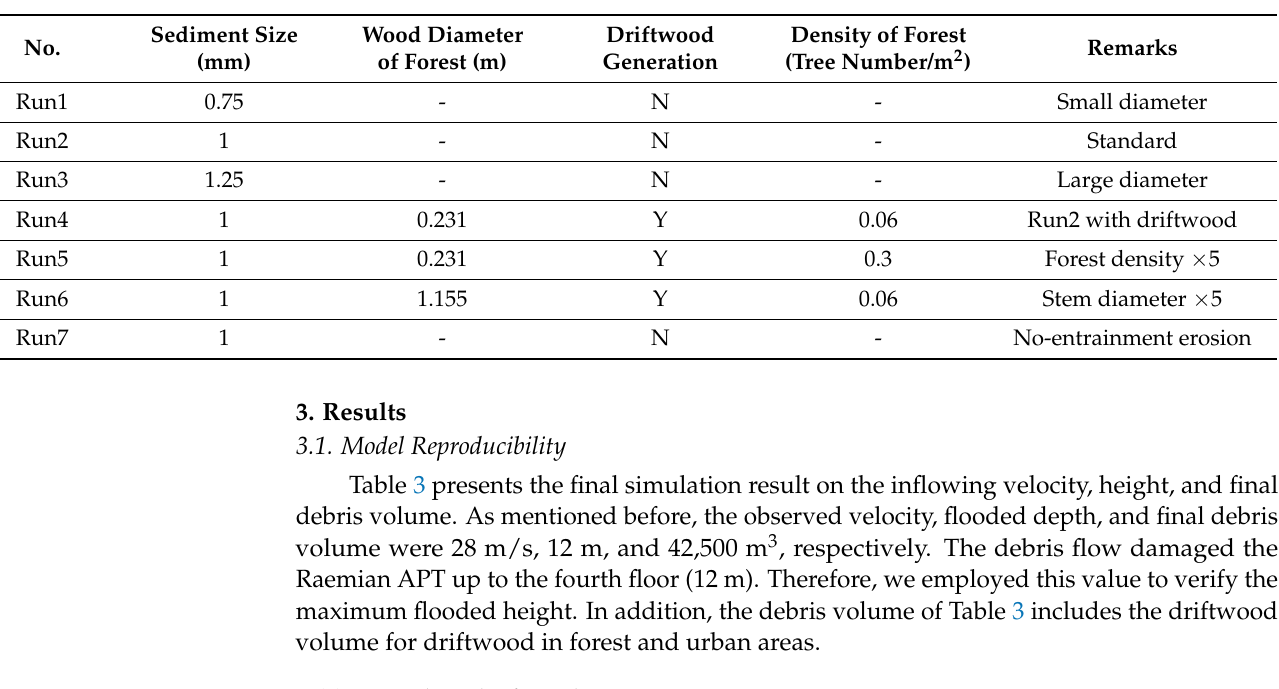
Table 3. Final result of